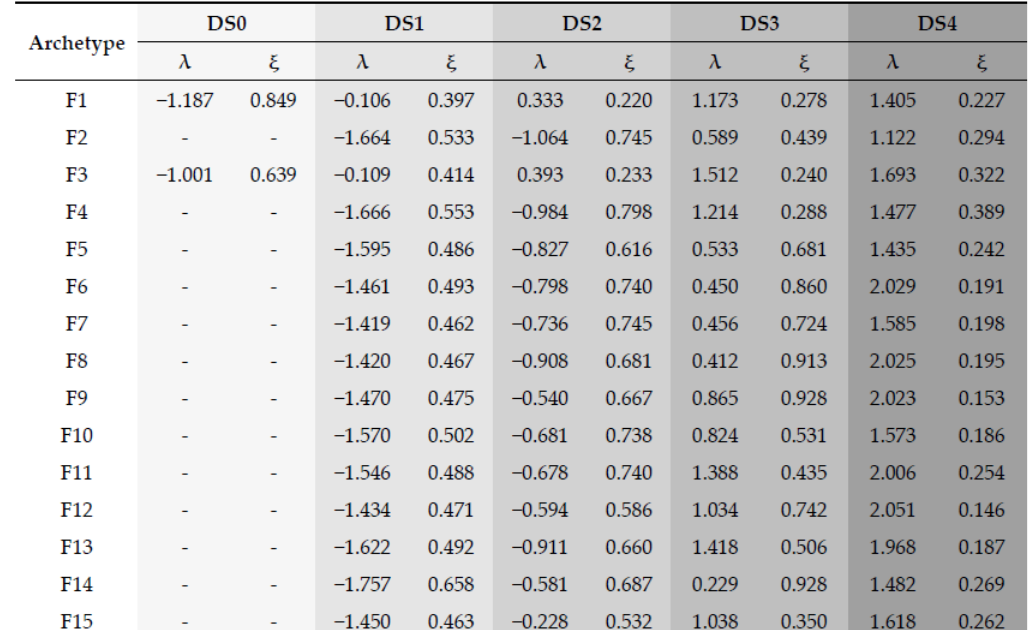
Table 4. Lognormal parameters of the developed fragility functions for the 15 building archetypes (metric